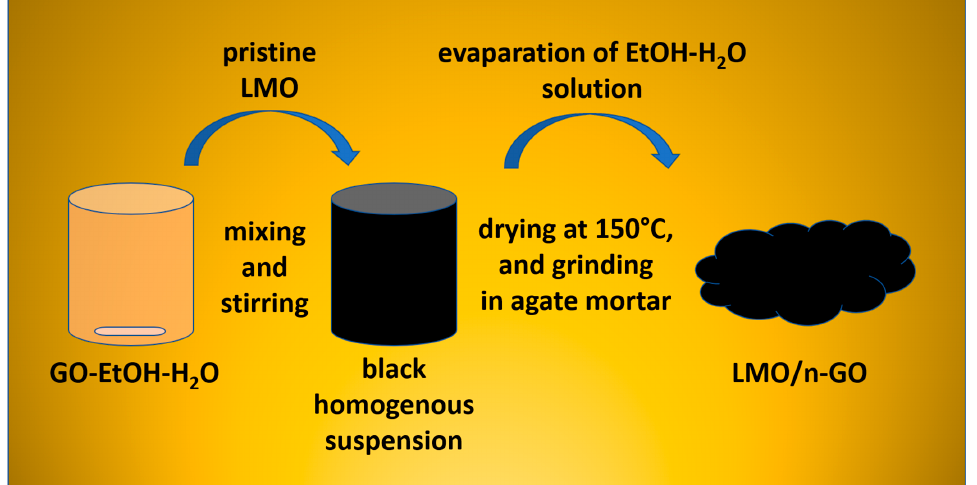
Figure 1. The flowchart of facile, wet chemical synthesis of LMO/1–5%wt.